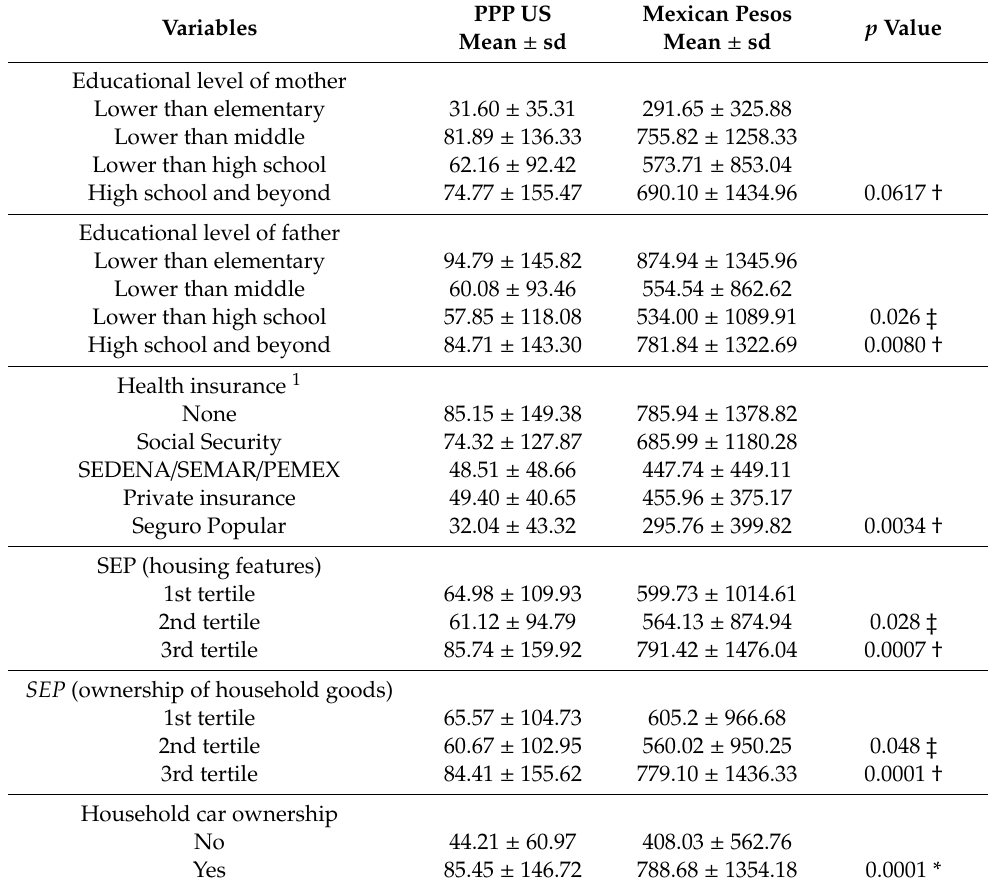
Table 5. Out-of-pocket expenditures on dental care according to socioeconomic characteristics, International Dollars and Mexican pesos, 2017.